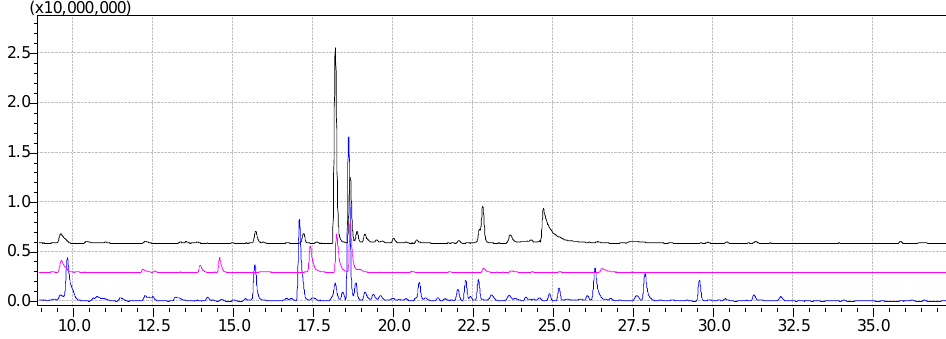
Figure 2. Chromatograms of non-traditional honey aroma compounds (black line—lime honey, pink line—buckwheat honey, blue line—honeydew honey from coniferous honeydew) .